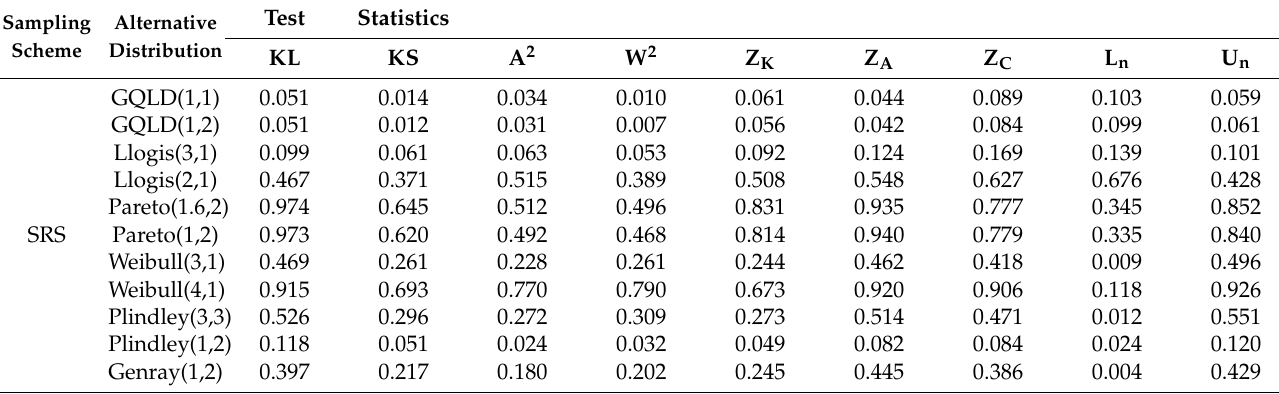
Table 5. Power estimates of different GFT in RSS and SRS for N = 20 and γ =